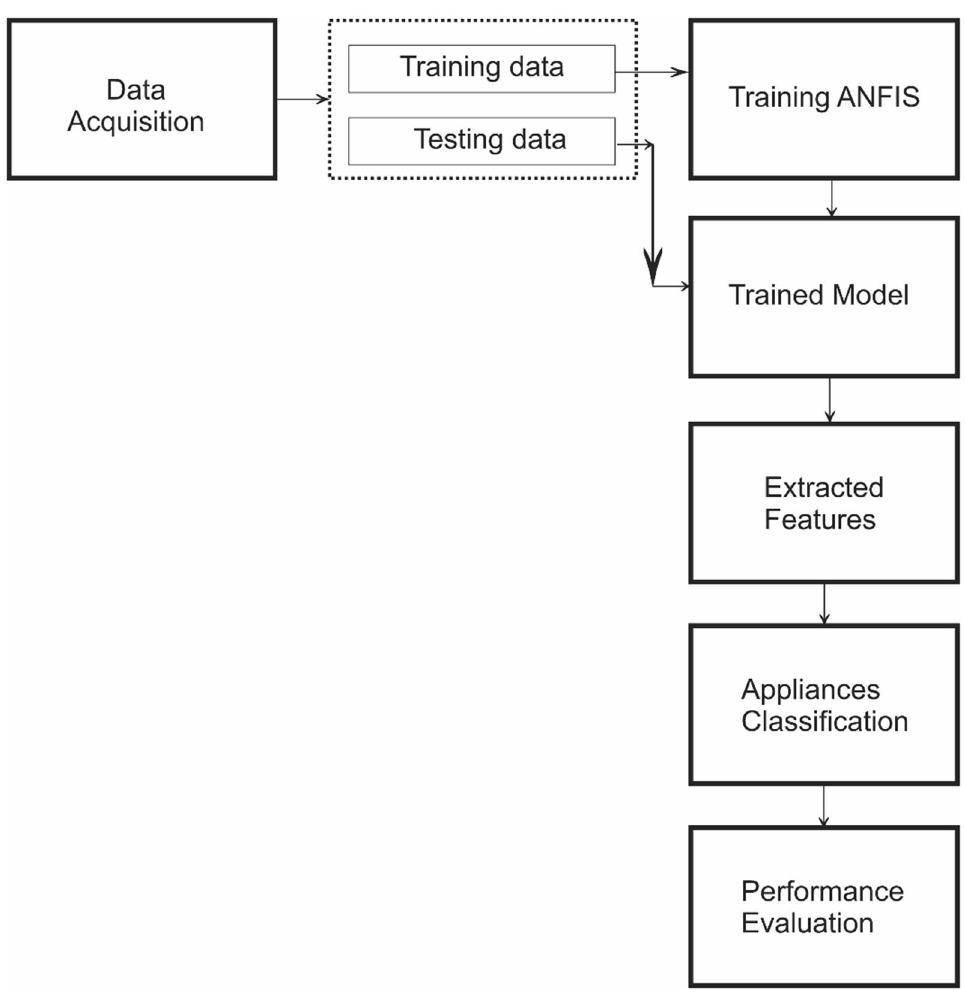
Figure 3. Proposed methodology flowchart.